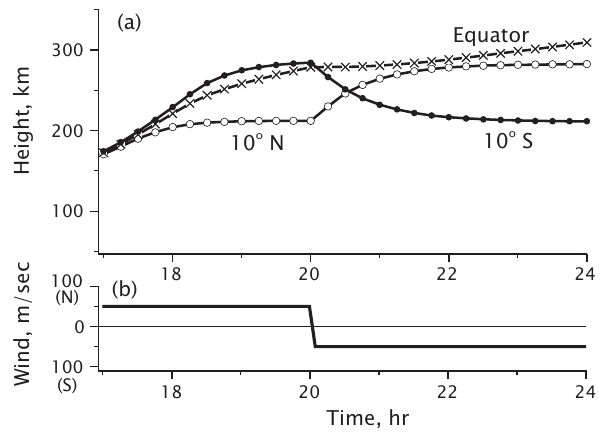
Fig. 4. Response of the bottom height of the ionosphere to the meridional wind change at the magnetic equator and at 10 ◦ north and south of the magnetic equator (upper panel). The uni- form transequatorial wind turned from northward to southward at 20:00 LT (lower